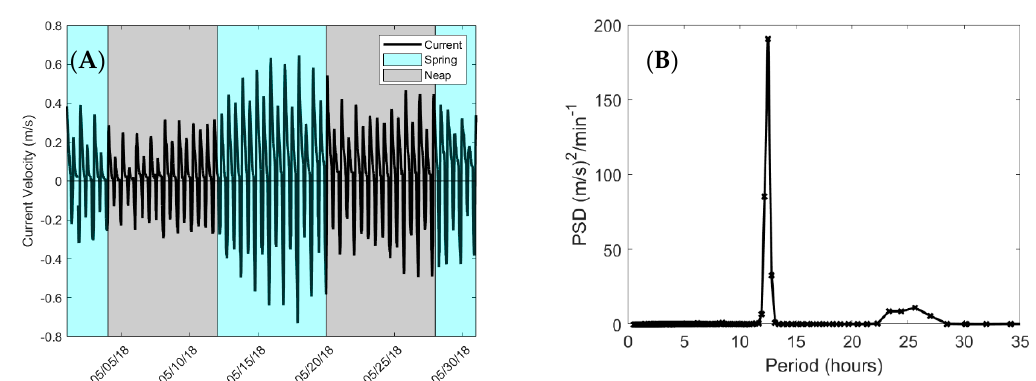
Figure 5. ( A ) time series of along-channel current velocity ( u ) measured by the ADV during the May, 2018 deployment; ( B ) power spectral density (PSD) of current velocity ( u ) shown in ( A ). The highest spectral peak occurs at a period of 12.5 h.